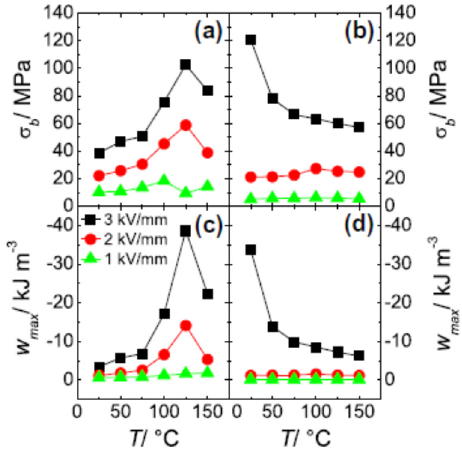
Figure 14. Blocking stress and maximum specific work for BNT ‐ 6BT ( a , c ); and for BNT ‐ 6BT ‐ 2KNN ( b , d ) as a function of temperature (reprinted from Reference [139] with copyright from Elsevier 2012).